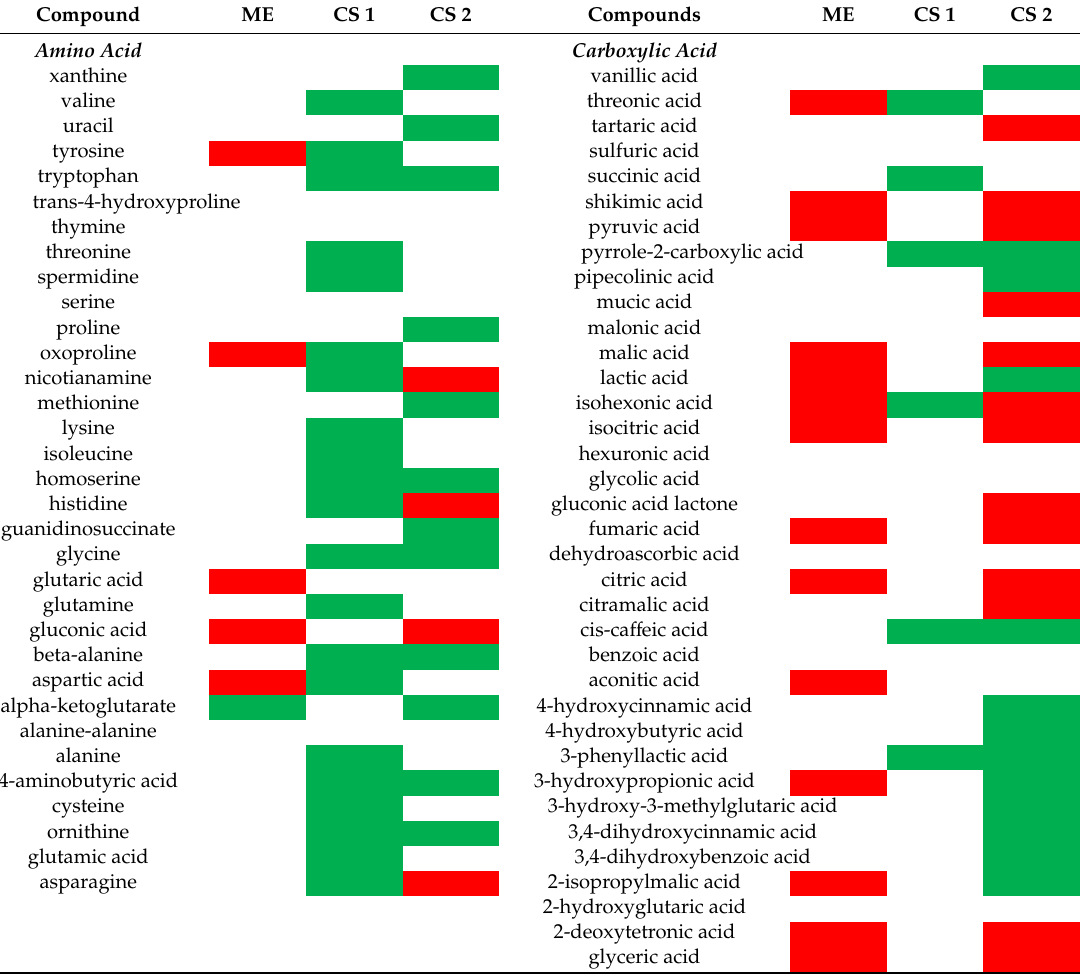
Table 5. Primary and secondary metabolites significantly impacted by GRBD as determined by untargeted metabolomics profiling for 2014